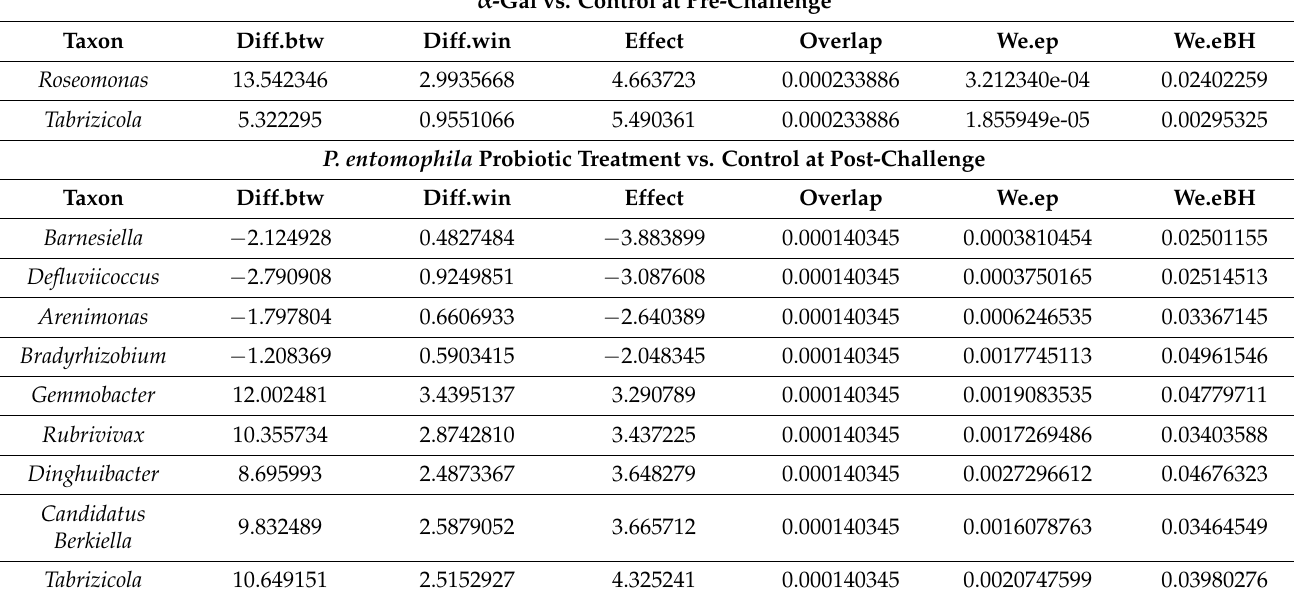
Table 3. List of significant differentially represented bacterial taxa in zebrafish microbiota. α -Gal vs. Control at Pre-Challenge